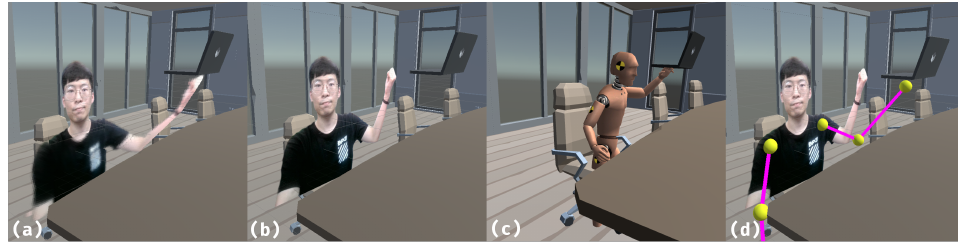
Figure 9. Different methods interact with virtual objects in the third-person perspective. ( a ) Pixel avatar. ( b ) 2D video conference. ( c ) Artificial avatar. ( d ) Skeleton avatar.